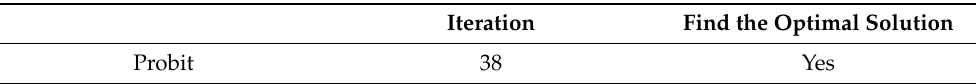
Table 6. Result of